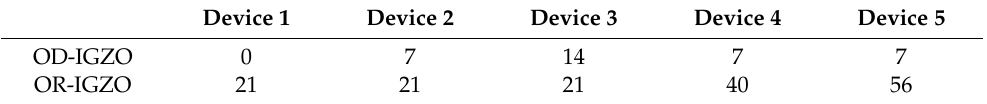
Figure 1. ( a ) Transfer curves of the DSCL-TFTs in dark, with the inset denoting the schematic cross-section of the five samples; ( b ) transfer curve evolution of Device 1 under 380 nm UV light illumination for 600 s. Table 1. Oxygen partial pressure for the channel ‐ layer depositions of the DSCL ‐ TFTs (Unit: mPa).